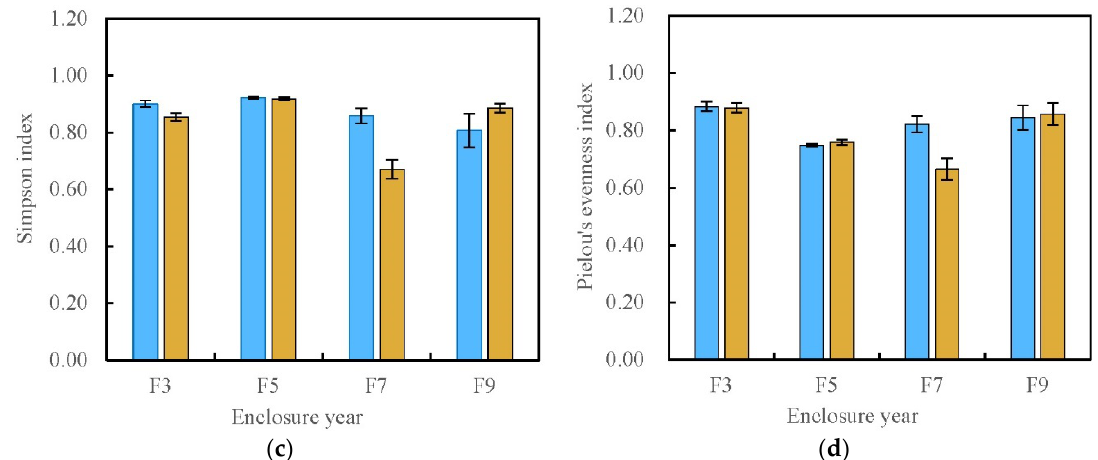
Figure 4. Temporal variations in community diversity of the temperate meadow steppe in Hulunbuir as observed in the plot experiment. Grass species both inside and outside the enclosure were under observation. Multiples indices of plant diversity were derived, including ( a ) Margalef richness index, ( b ) Shannon–Wiener diversity index, ( c ) Simpson diversity index, and ( d ) Pielou's evenness index.